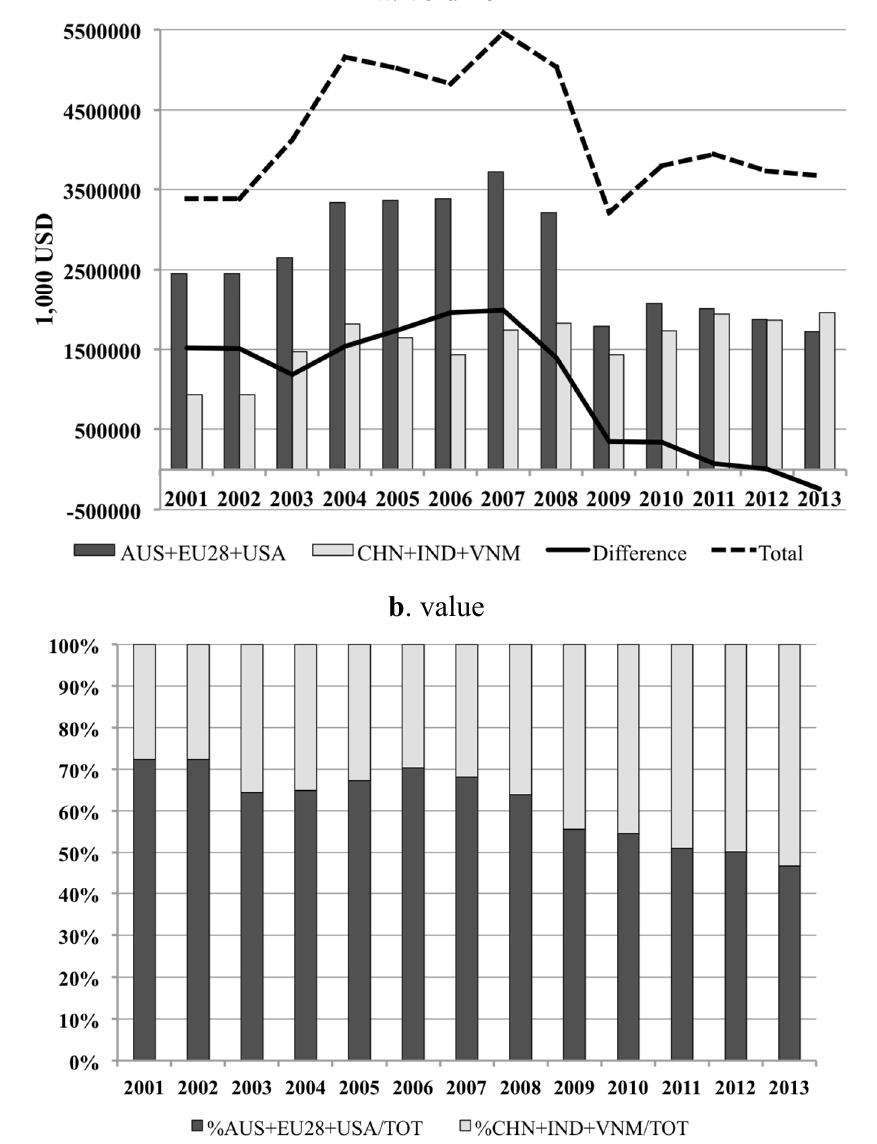
Figure B3. ( a ) Tropical timber product imports by groups of selected countries, in value; and ( b ) % incidence of selected countries on total imports (2001–2013). AUS = Australia; CHN = China; EU-28 = European Union; IND = India; USA = United States of America; VNM = Vietnam. Difference means difference between (AUS + EU-28 + USA) and (CHN + IND + VNM). Source: own elaboration from